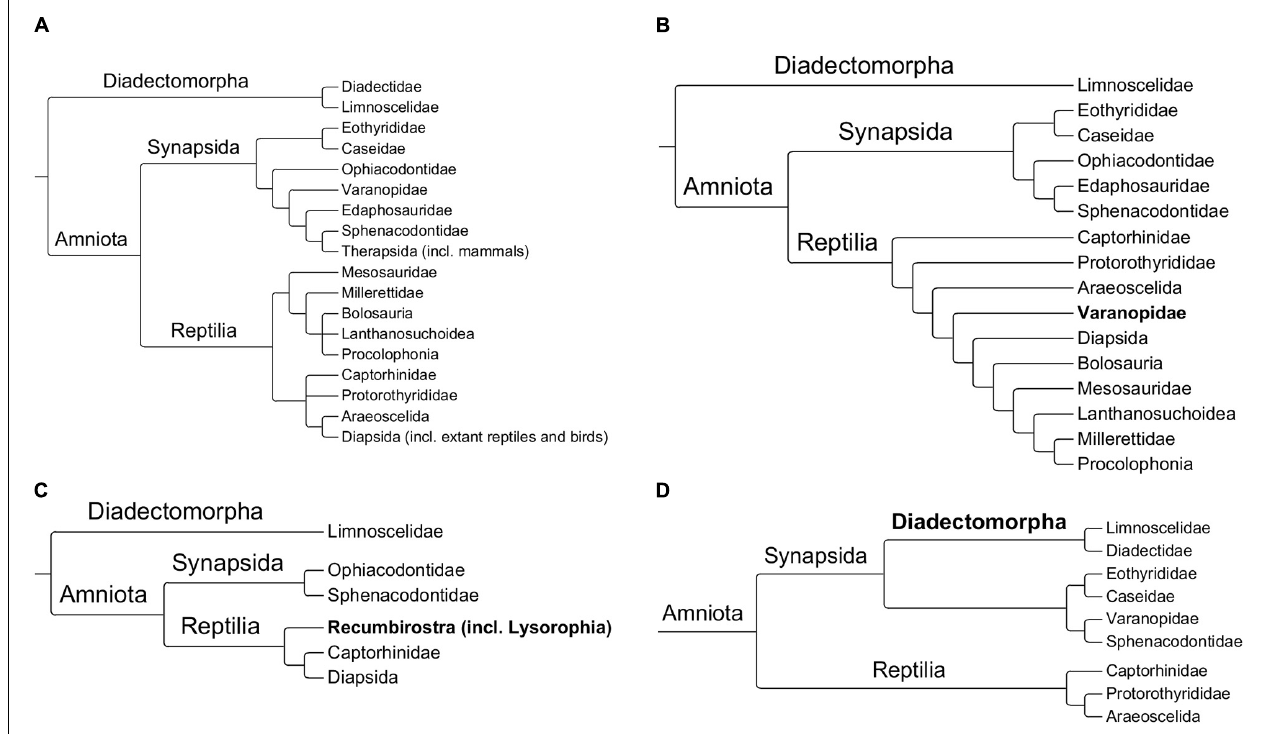
FIGURE 1 | Summaries of four hypotheses of early amniote relationships. (A) Pre-2017 relationships (based on Müller and Reisz, 2006; MacDougall and Reisz, 2014; Brocklehurst and Fröbisch, 2018a; Brocklehurst et al., 2018a); (B) Varanopids within reptiles (based on Ford and Benson, 2020); (C) Recumbirostrans and lysorophians within reptiles (based on Pardo et al., 2017); (D) Diadectomorphs within synapsids (based on Klembara et al., 2020).